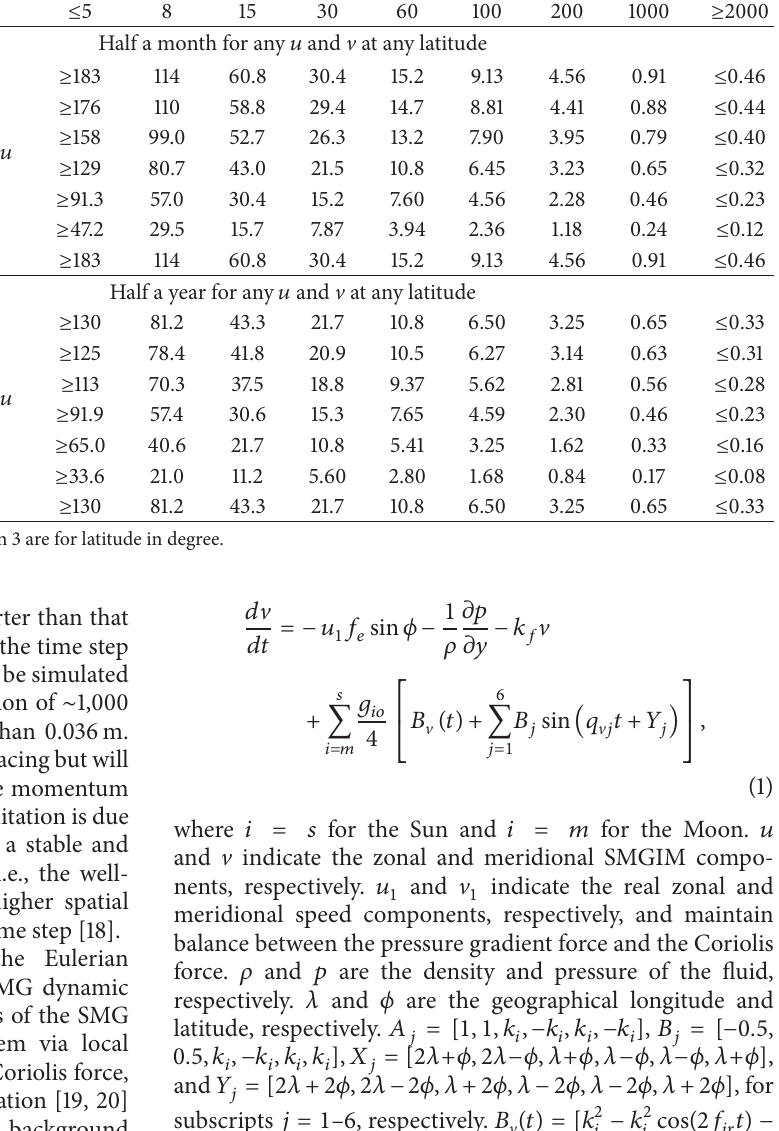
Table 1: Basic (1st, 2nd, and 3rd) memorial periods versus the velocity of SMG-induced magma motion. Length of period (ky) ≤ 5